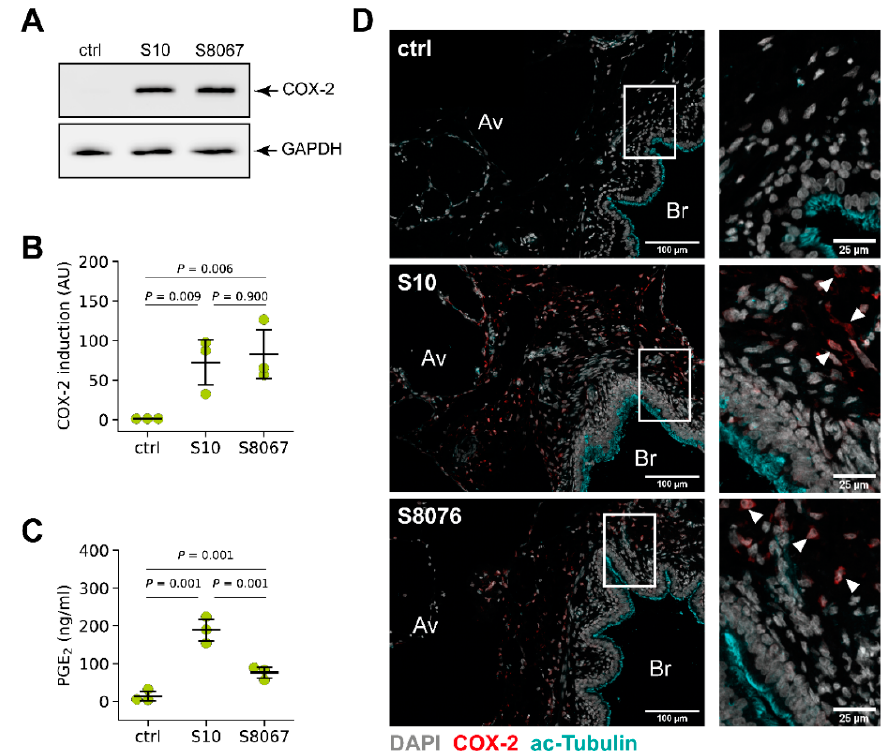
Figure 5. COX-2 is induced by two prevalent S. suis serotypes in porcine PCLS. PCLS were left uninfected (ctrl) or infected with S. suis S10 and S8067, respectively. ( A ) COX-2 protein expression was analysed 24 h after infection by Western blotting. GAPDH served as loading control. One representative of three independent experiments is shown. ( B ) Densitometric analysis of the Western blot experiments shown in ( A ). Data are presented as mean ± SD of three independent experiments. Exact p values are indicated (Welch analysis of variance (ANOVA) followed by Games–Howell post hoc test). ( C ) PGE 2 production after 24 h of stimulation was determined in the supernatant by enzyme-linked immunosorbent assay (ELISA). Data are presented as mean ± SD of three independent experiments. Exact p values are indicated (Welch ANOVA followed by Games-Howell post hoc test). ( D ) Visualisation of COX-2 (red), acetylated tubulin (cyan) and nuclei (grey) in uninfected (ctrl) and infected (S10, S8067) tissue by confocal microscopy. Boxed regions are shown enlarged in the right panel. Arrowheads indicate exemplary COX-2 expressing cells. One representative of three independent experiments is shown. Av, alveolar tissue; Br, bronchioles.